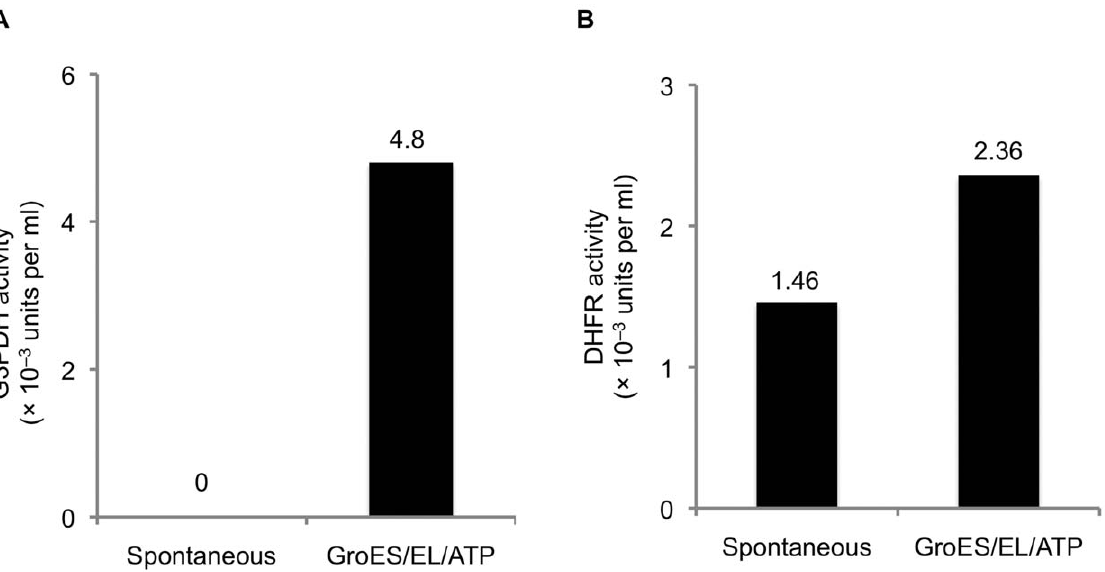
Figure 5. The addition of GroEL and GroES increases the yield of properly folded passenger proteins invitro . ( A ) G3PDH activity. ( B ) DHFR activity.